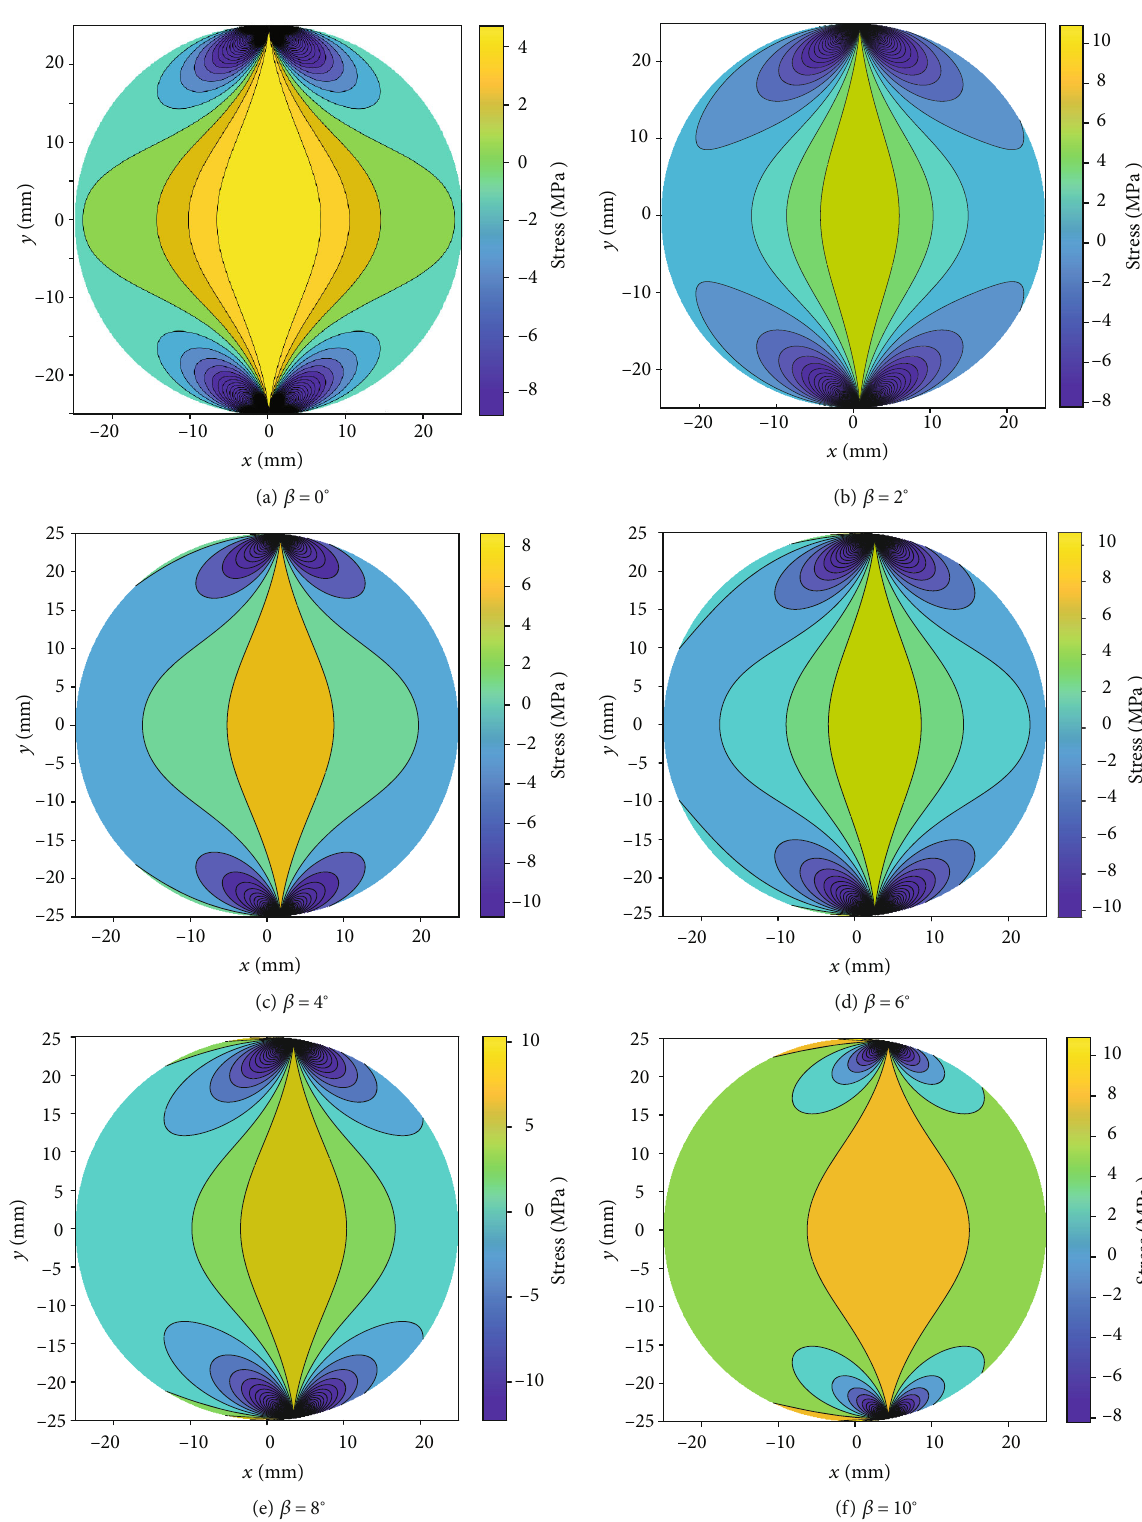
Figure 5: Horizontal stress cloud diagram at di ff erent deviation angles β